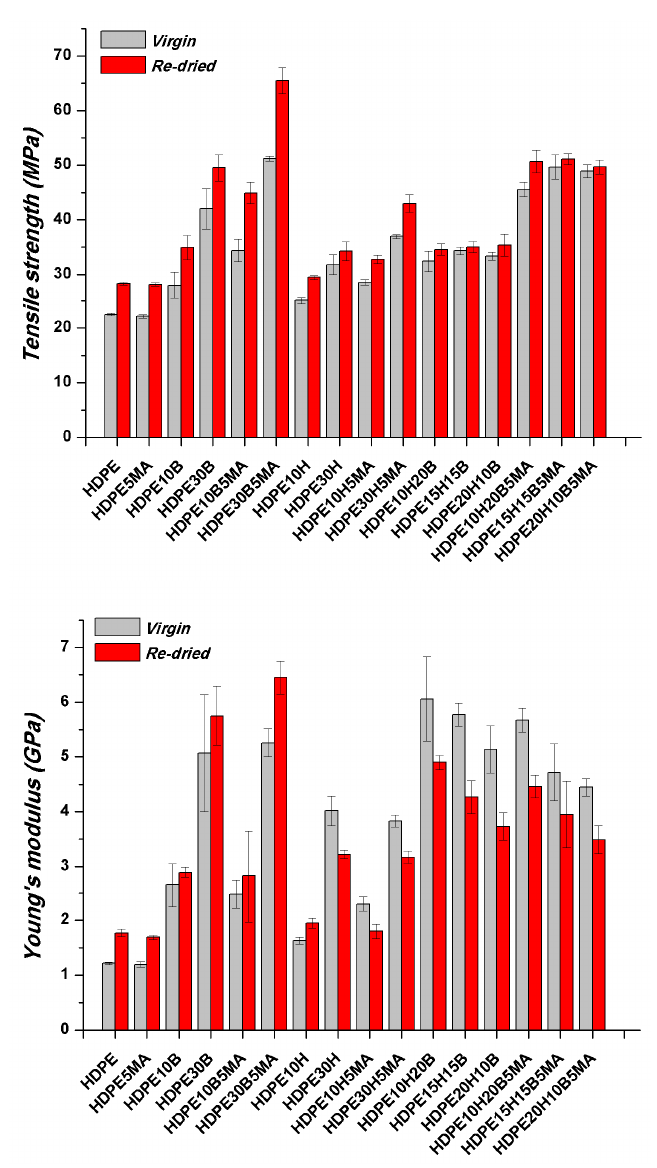
Figure 2. Tensile strength and Young’s modulus of high-density polyethylene (HDPE) and hemp/basalt fibre hybrid composites before and after water ageing.